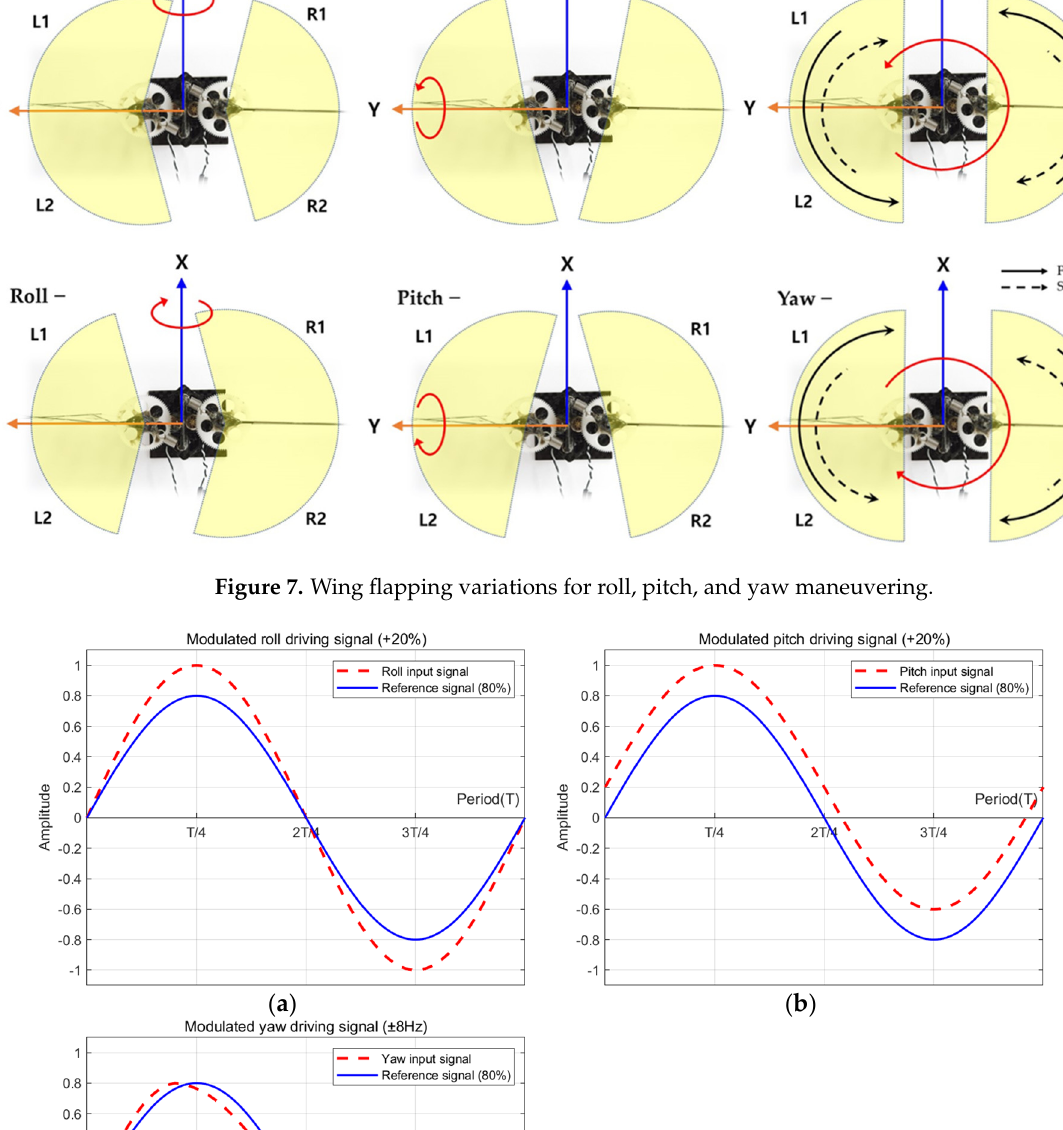
Figure 9. Experimental setup for measuring torques and lift forces with roll, pitch, and yaw control inputs.